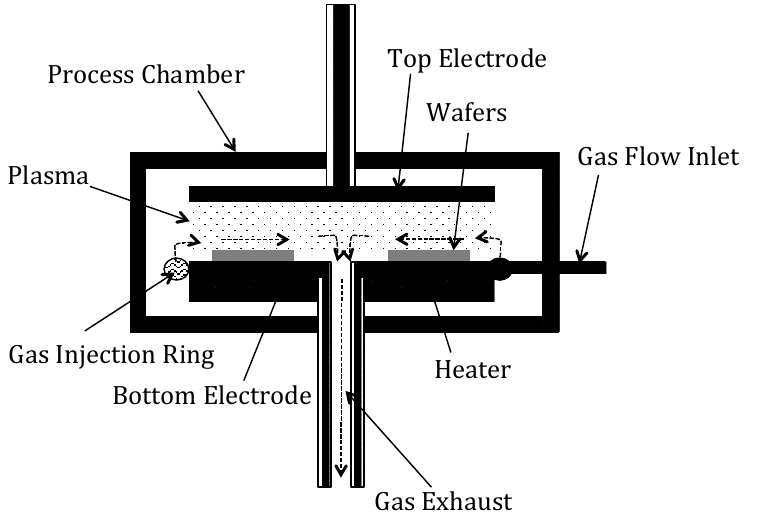
Figure A4. A cold-walled parallel plate plasma-enhanced chemical vapor deposition (PECVD) sys- tem.